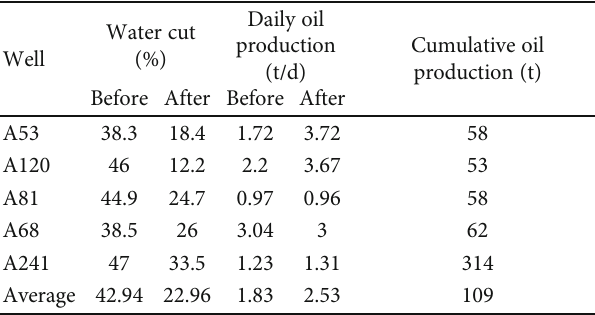
Table 5: Comparison of oil production and water cut before and after dynamic